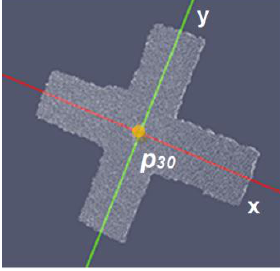
Figure 7. The x and y axes of the cross-shaped object point cloud at 30° and the closest point between these axes, highlighted with yellow color.